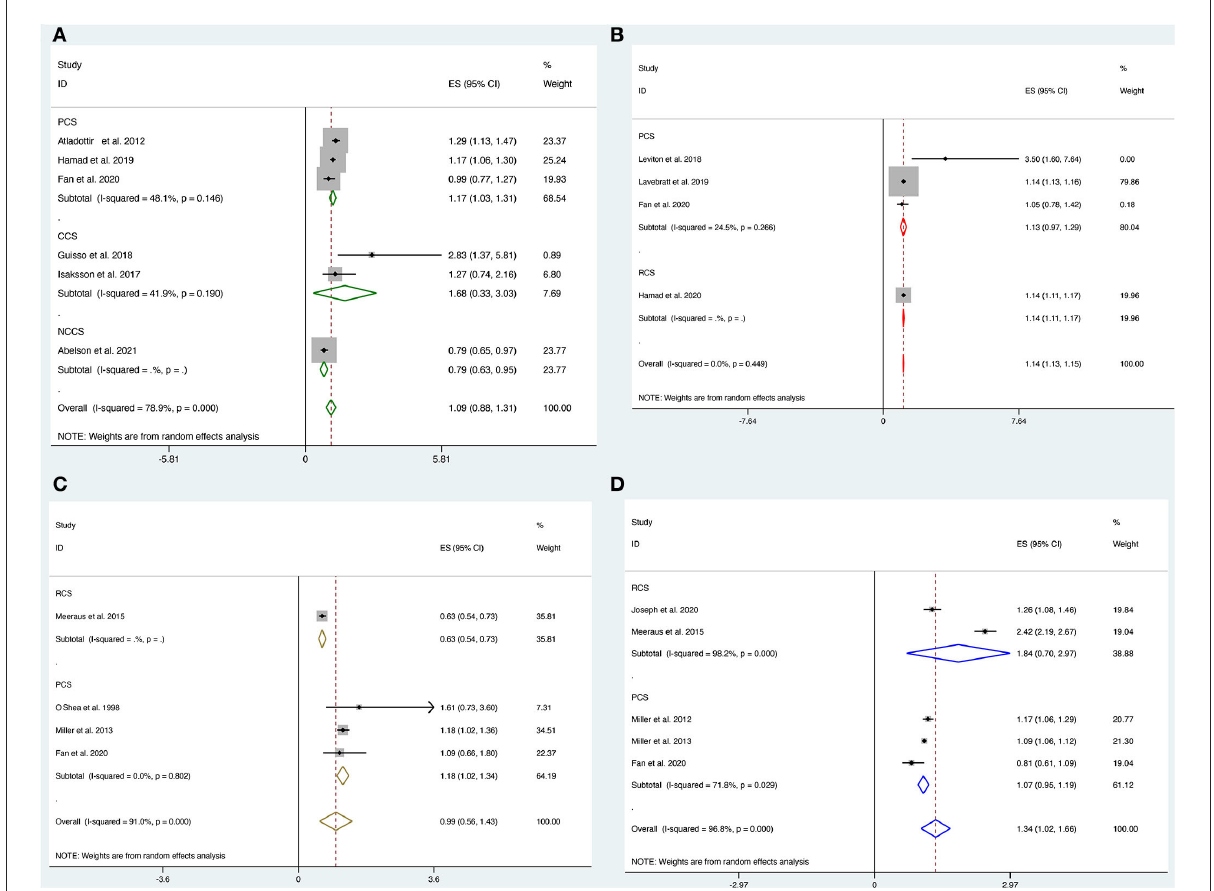
FIGURE2 (A–D) Forest plot for the association of prenatal exposure to antibiotics and risk of neurodevelopmental disorders in the offspring. (A) Risk of ASD. (B) Risk of ADHD. (C) Risk of CP. (D) Risk of